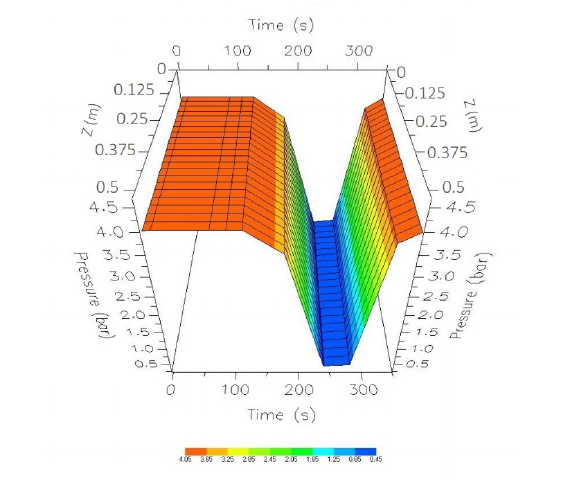
Figure 21. Comparison of the optimal results with the nominal values from the start-up to the CSS.